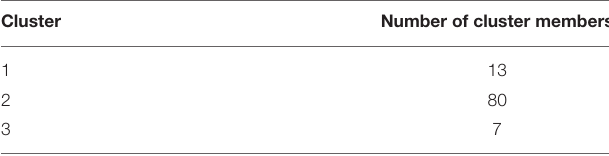
TABLE 2 | Number of members in each cluster of the complete linkage method.